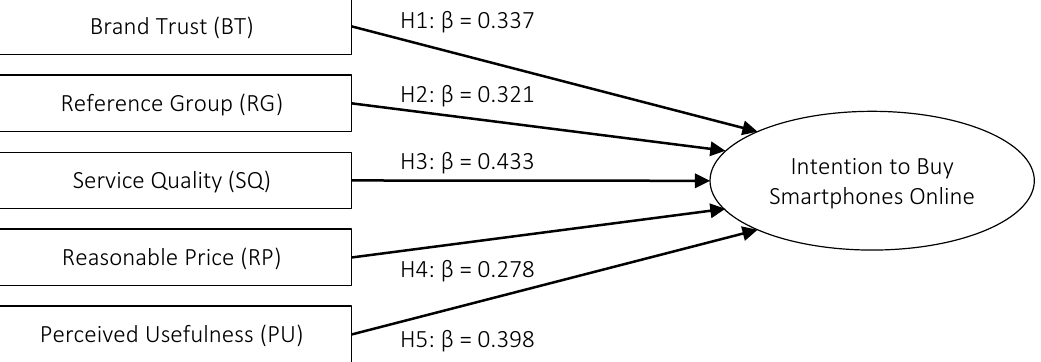
Figure 2. Regression coefficients